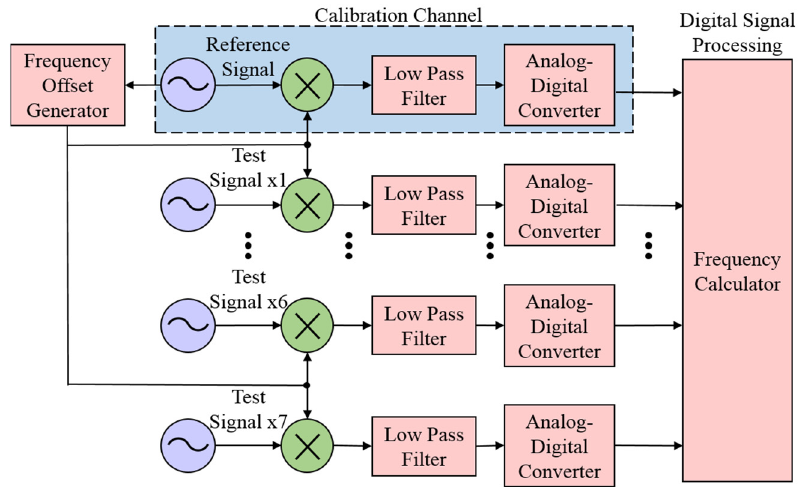
Figure 2. A schematic diagram of the multi-channel digital frequency measurement